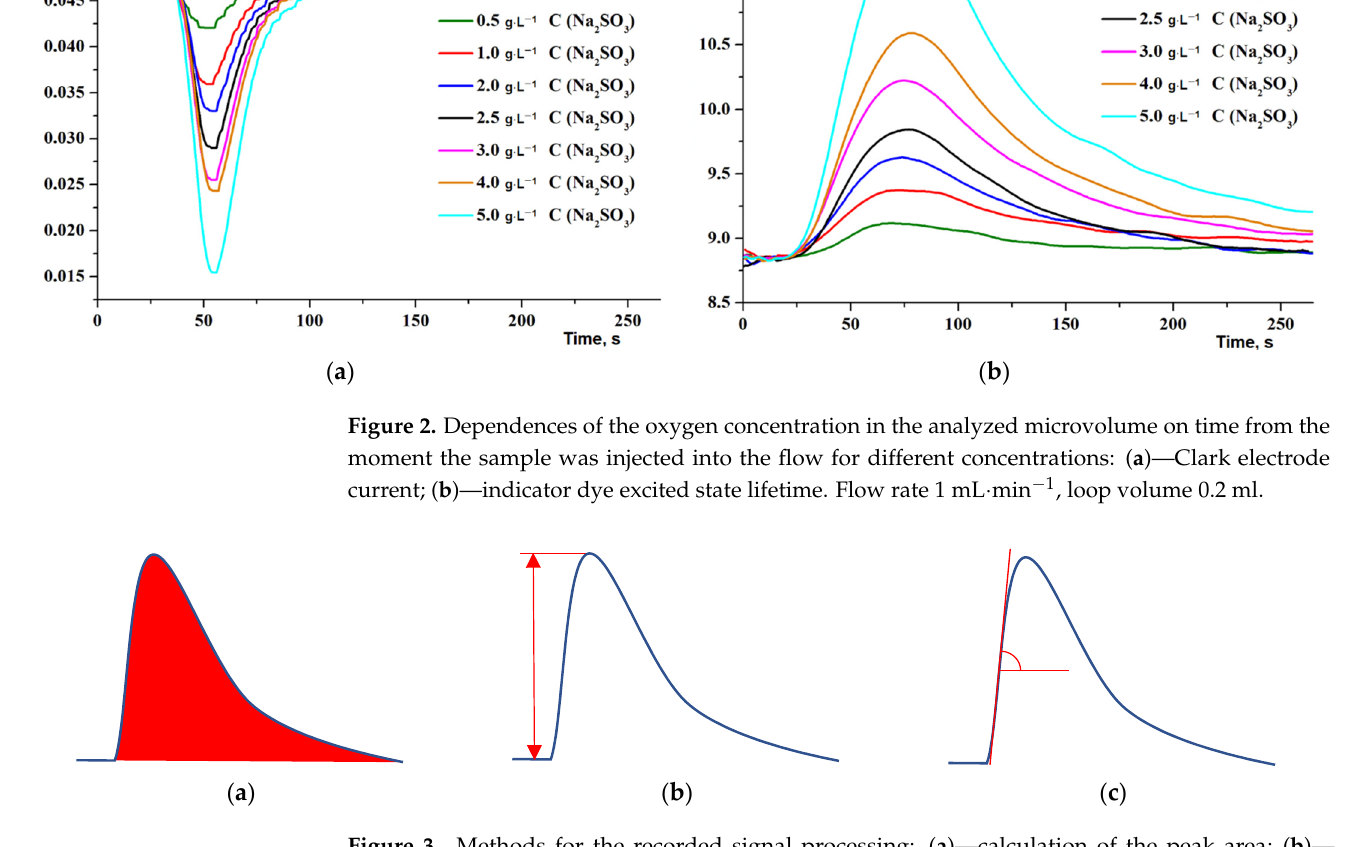
Figure 3. Methods for the recorded signal processing: ( a )—calculation of the peak area; ( b )—deter- mination of the peak height; ( c )—determination of the slope (the rate of change of the primary sig- nal) after the sample enters the